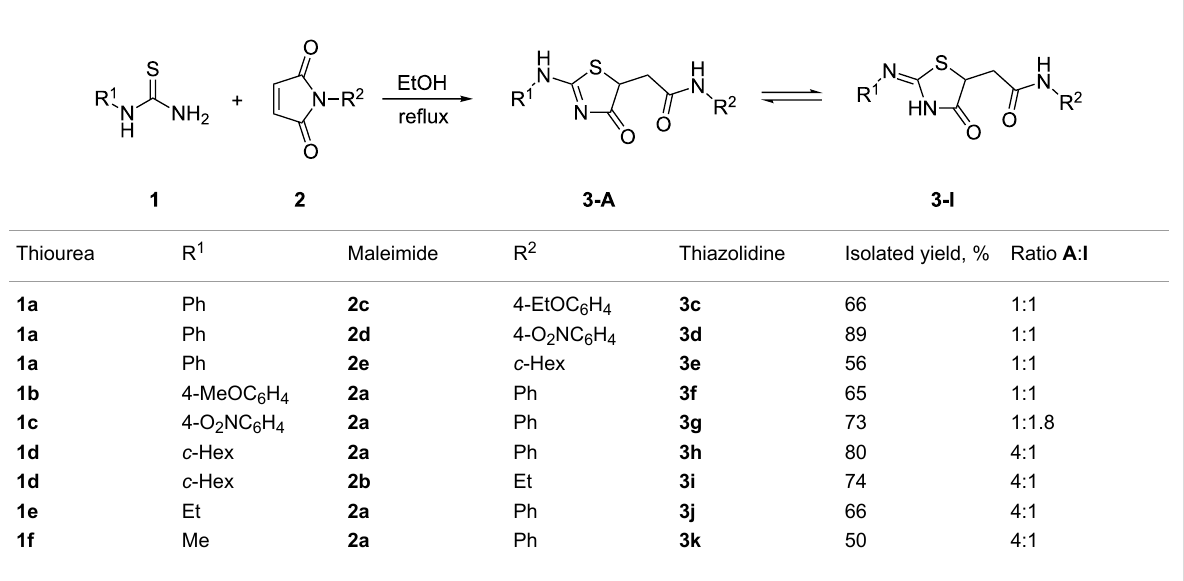
Table 1: Reaction of monosubstituted thioureas 1a – f with maleimides 2a – e .